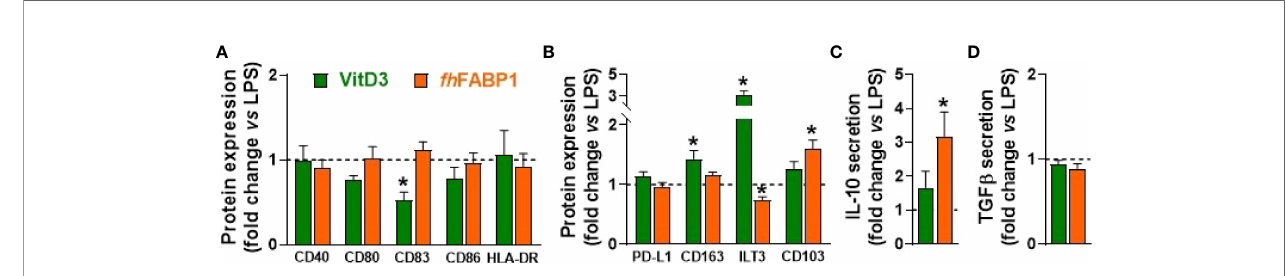
FIGURE 4 | Fasciola hepatica FABP1 induces CD103 tolerogenic marker in dendritic cells. Human monocyte-derived DCs (moDCs) were treated with recombinant fh FABP1 (25 µg/ml, orange bars) or Vitamin D (VitD3, 10 nM, green bars) in the presence of LPS (100 ng/ml), as described in Figure 1 After 48 hours, the cell- surface expression of co-stimulatory molecules (A) and tolerogenic markers (B) were assessed by fl ow cytometry, and IL-10 and TGF b secretion by moDCs (C, D) were determined by ELISA All data are expressed relative to the DCs stimulated with LPS alone (dash line) as mean ± SEM * P ≤ 005 vs LPS alone (n=4